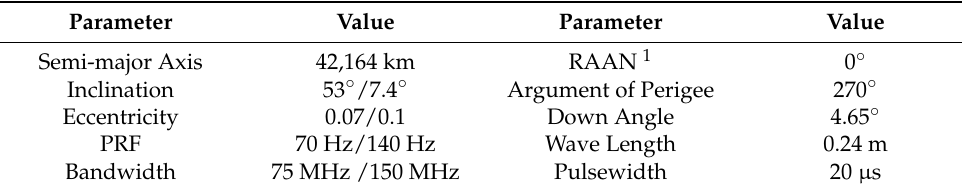
Table 1. Simulation parameters of GEO